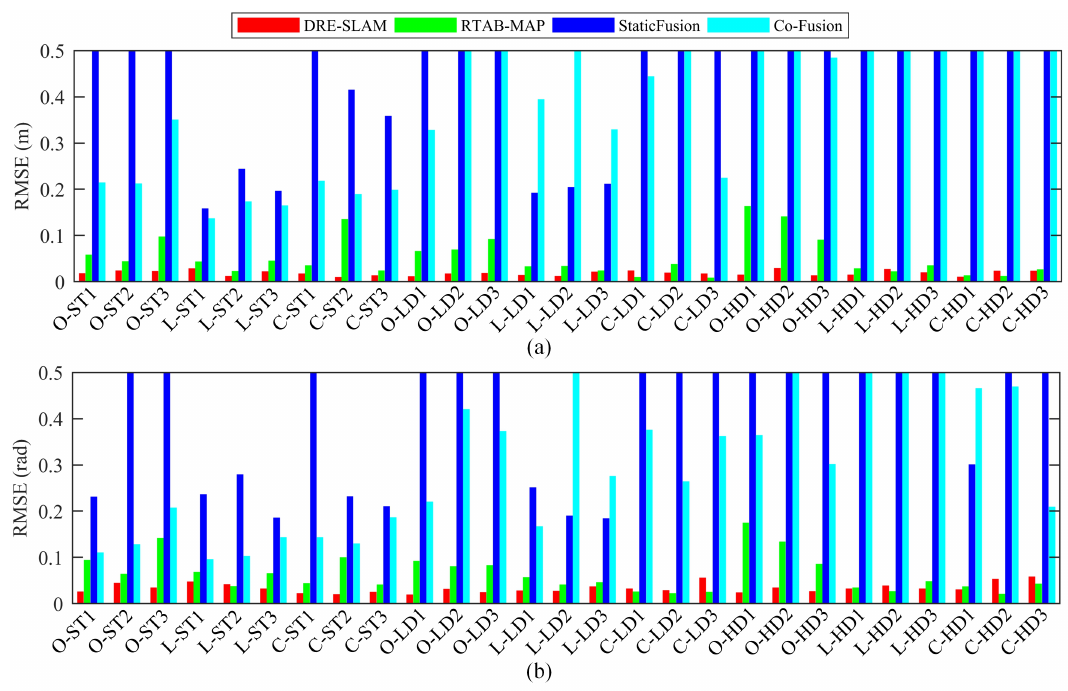
Figure 9. The root-mean-square-error (RMSE) of ( a ) the translation (m) and ( b ) the rotation (rad) comparison of the four methods in all the sequences.